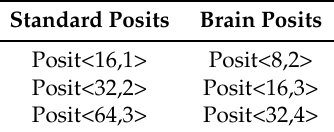
Table 5. Brain Posits.